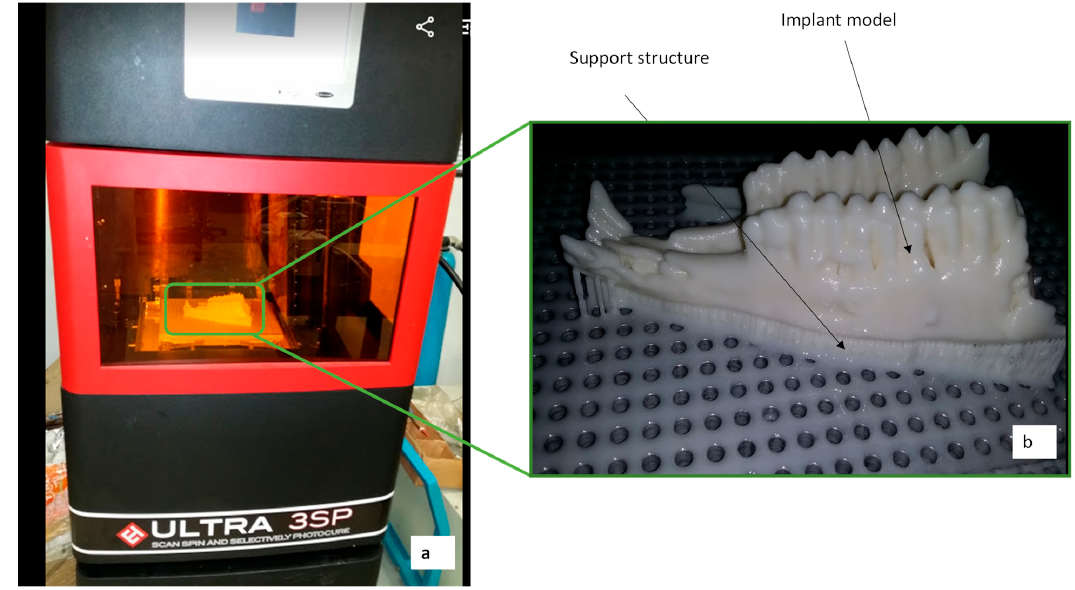
Figure 4. ( a ) Ultra 3SP 3D printer used for the polymer fabrication of ( b ) goat